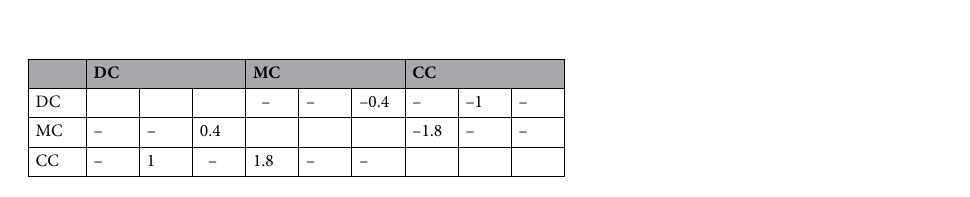
Table 8. Hypothetical subjective pairwise judgements of